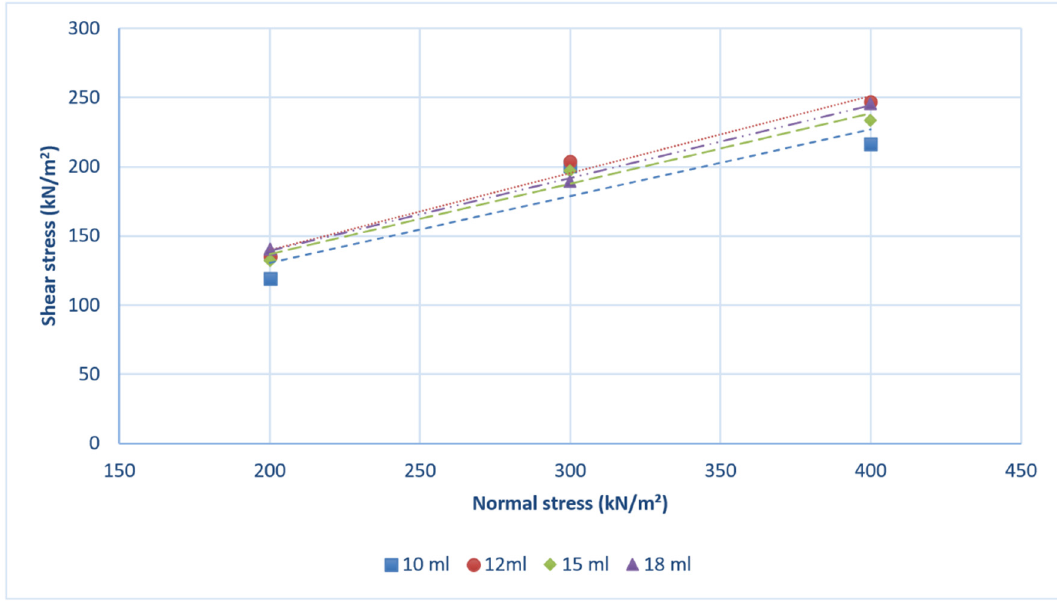
Figure 8. Shear failure envelopes for Sweileh sandy soil using various volumes of water.